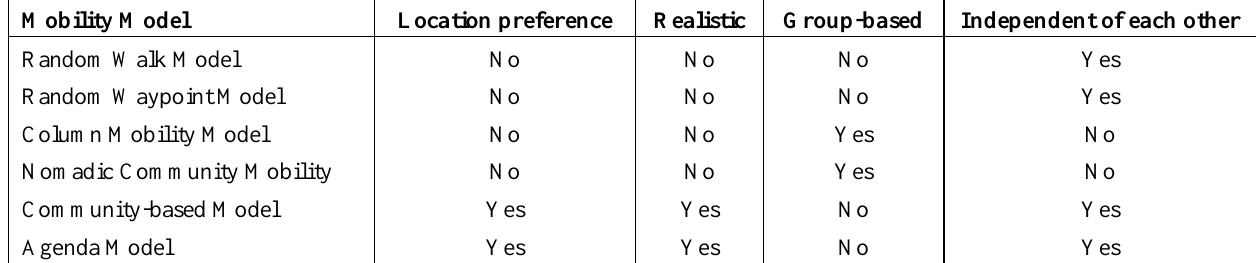
Table 1. Node characteristics in five mobility